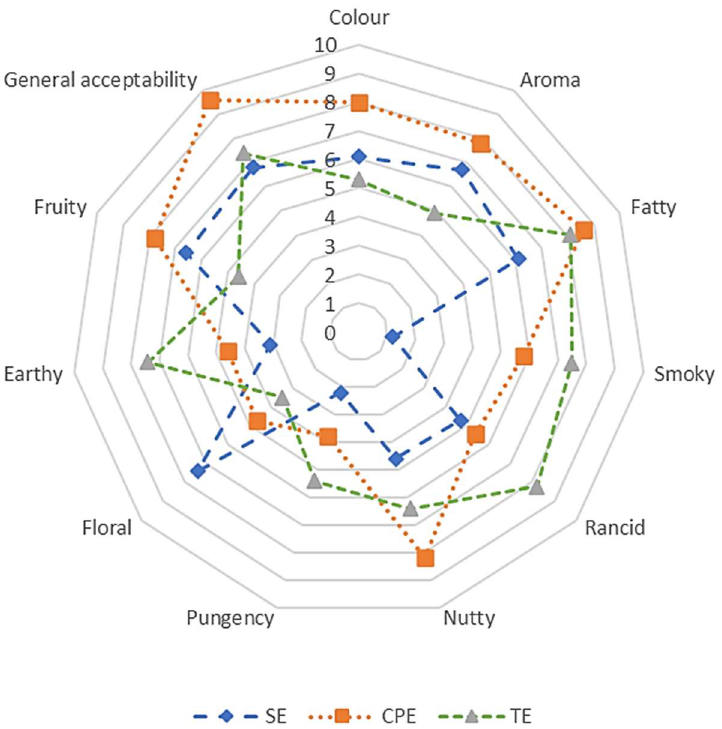
Figure 1. Sensory profiles of shea butters.